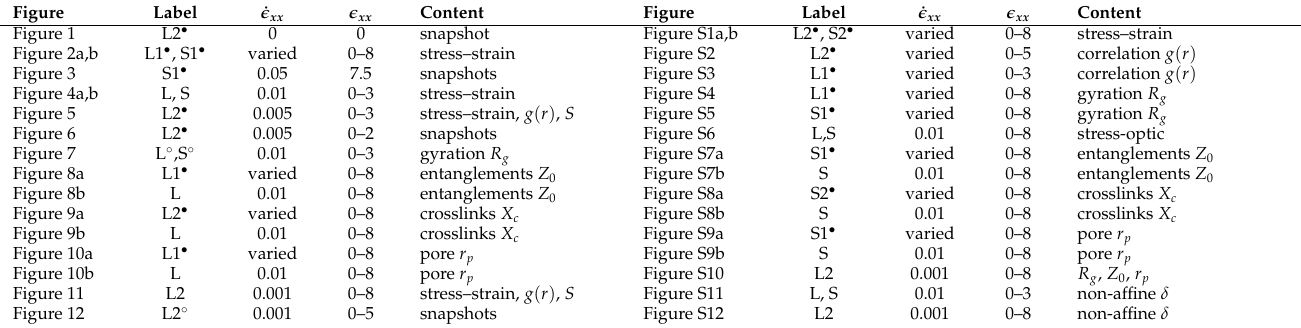
Table 2. Guide through results shown by figures in both main text and Supplementary Information. System labels have been introduced in Table 1, strain rates ˙ ε xx , strain ε xx and quantities are mentioned here. Parts of labels have been left out if the corresponding figure shows results for all labels that contain the pattern such as S2; it stands for S2 • and S2 ◦ . Additional data available from authors upon